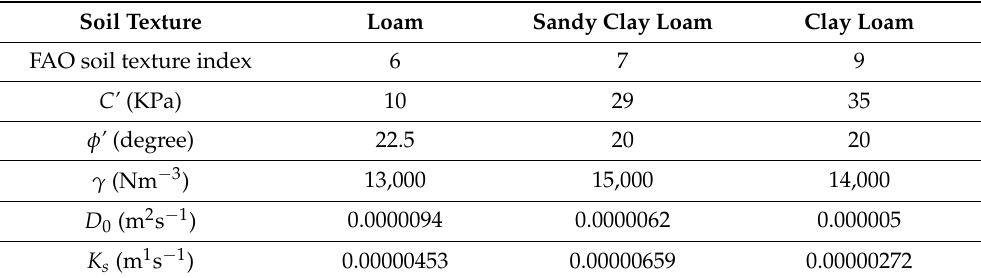
Table 1. Hydrogeomechanical parameters (hydraulic and strength parameters) of the study area for three designated soil textures. C’ is cohesion for effective stress, φ ’ is angle of internal friction, γ is unit weight of soil, D 0 is hydraulic diffusivity, and K s is saturated hydraulic conductivity. Soil